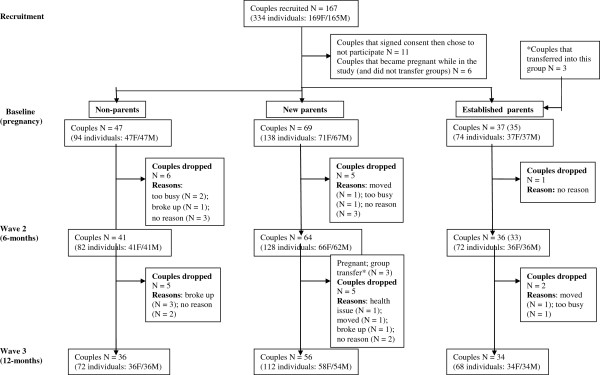
Participant recruitment and drop out.